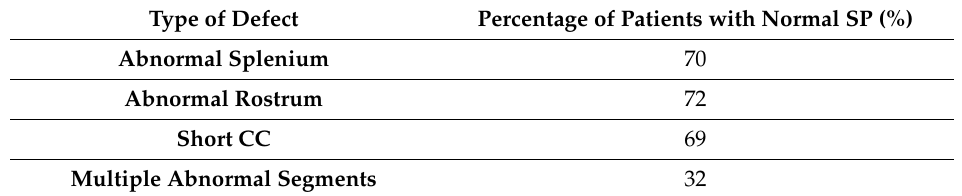
Figure 3. Human brain structures in the medial plane with the septum pellucidum (in color). Dark blue: corpus callosum; light blue: septum pellucidum. Table 3. Percentage of patients with normally shaped SP in the study population (depending on the type of pACC) [60,61].